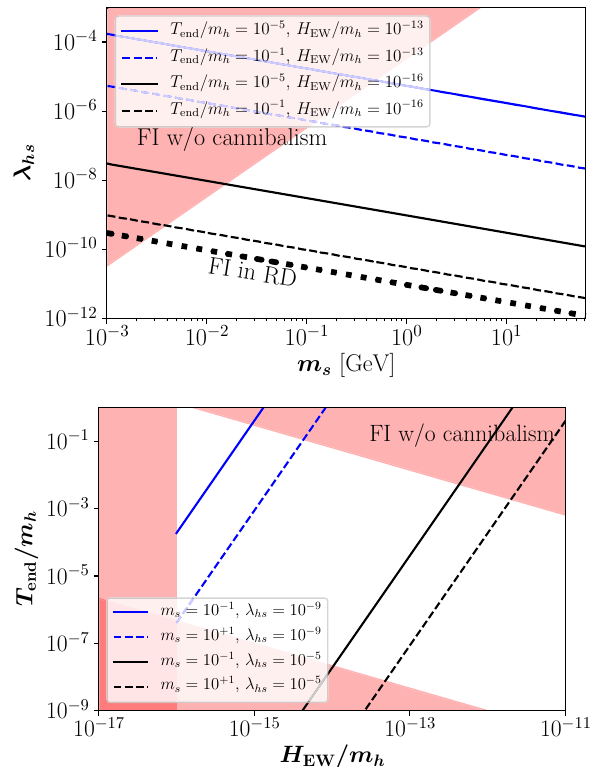
Fig. 5 DM freeze-in without cannibalism. Parameter space giving rise to the observed DM relic abundance. The black dotted line shows the parametersyieldingthecorrectDMabundanceintheusualRDscenario. The red regions correspond to the constraints discussed in Sect. 2.2. Other observational constraints are shown in Fig.